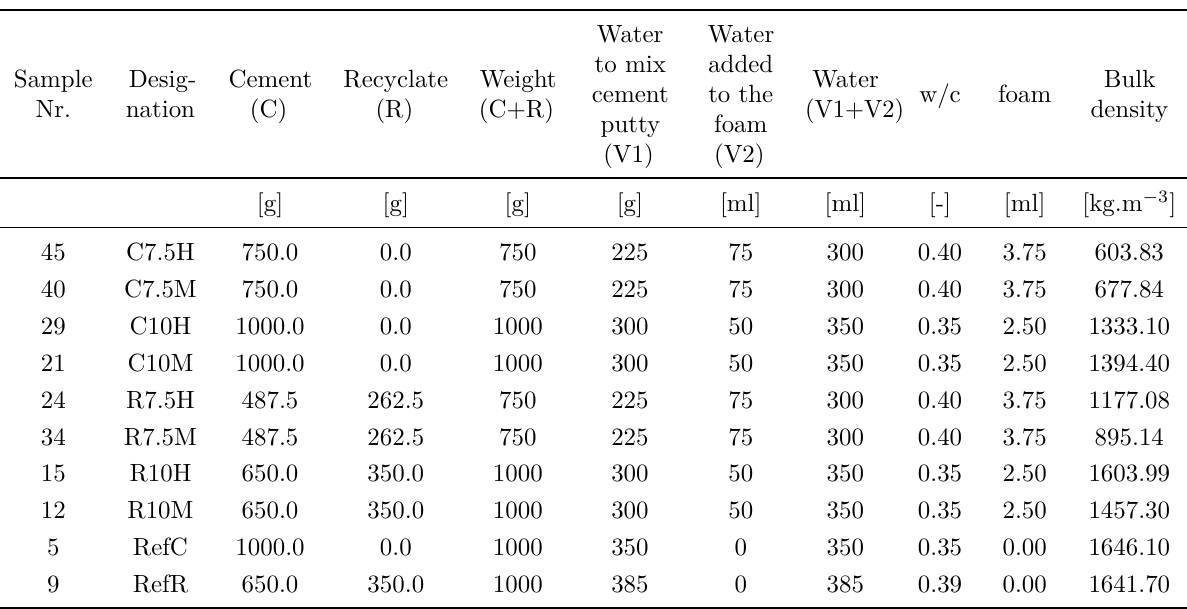
Table 1. Composition of the samples and the bulk density [5].